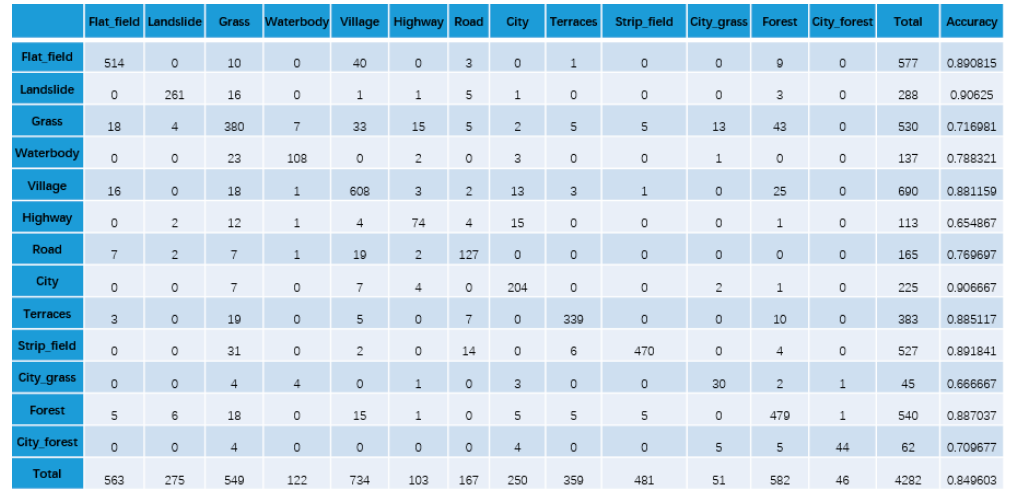
Figure 19. The object-based confusion matrix of the Cluster-GCN model.